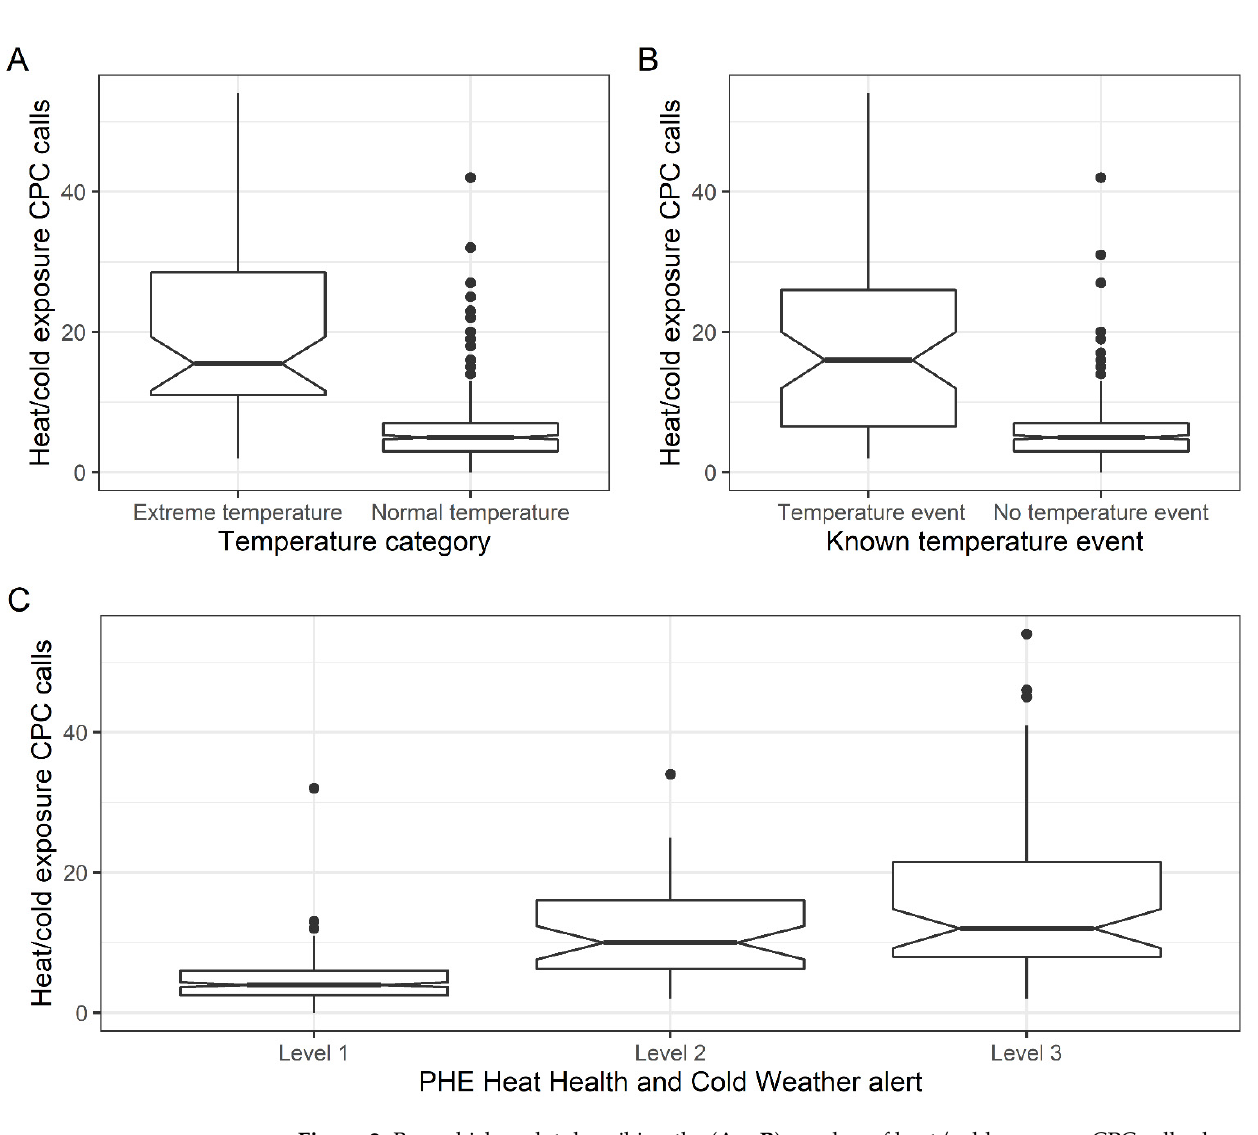
Figure 2. Box-whisker plot describing the ( A + B ) number of heat/cold exposure CPC calls observed between extreme and normal temperature days (top left) and KTE, non-temperature event (top right), and ( C ) across different PHE Heat Health and Cold Weather Alert levels (bottom).